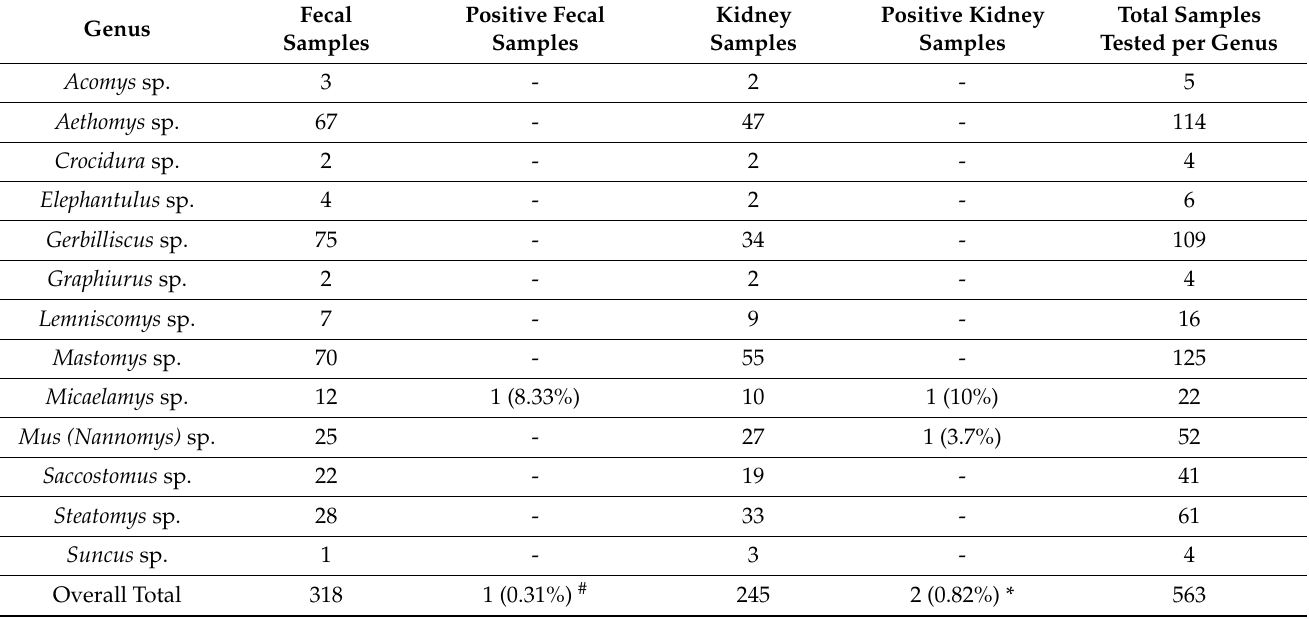
Table 1. Total samples from non-volant mammals tested for arenaviruses according to host